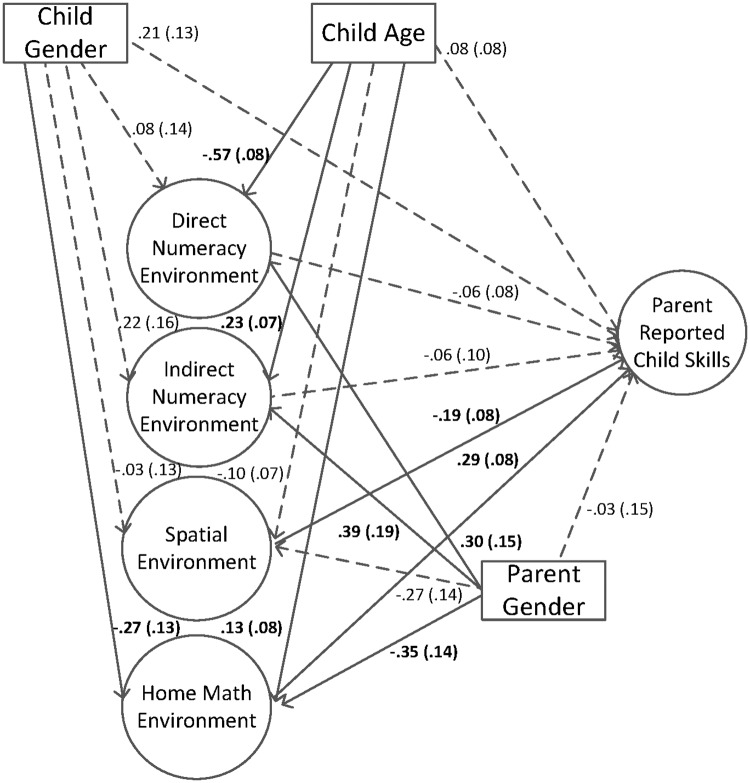
Home math environment factors predicting parent report of child skills.Standard errors are in parentheses. Solid lines and bolded text represent significant pathways, p < .05. Longdash lines represent non-significant pathways, p > .05.